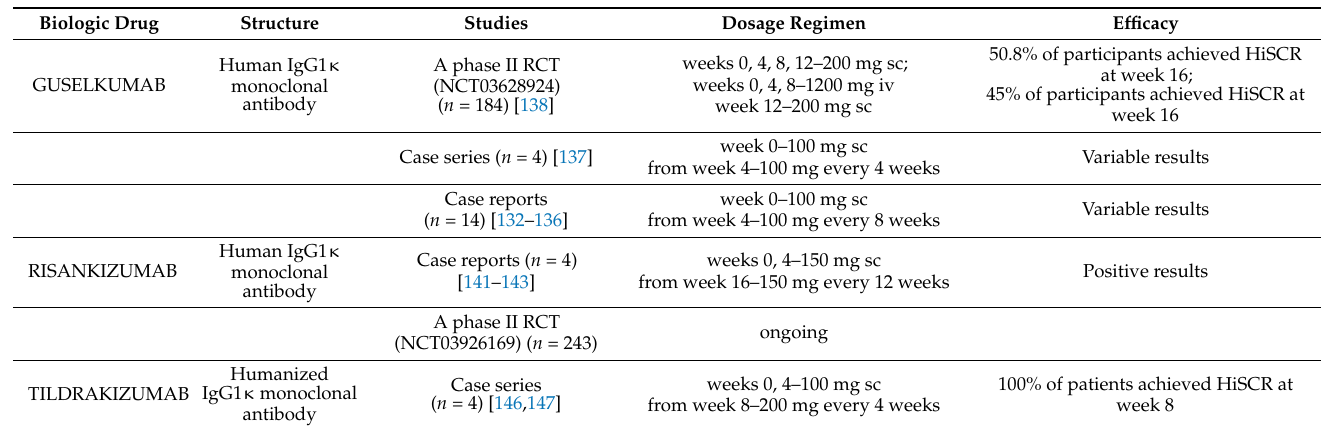
Table 6. Anti-IL-23 agents for HS